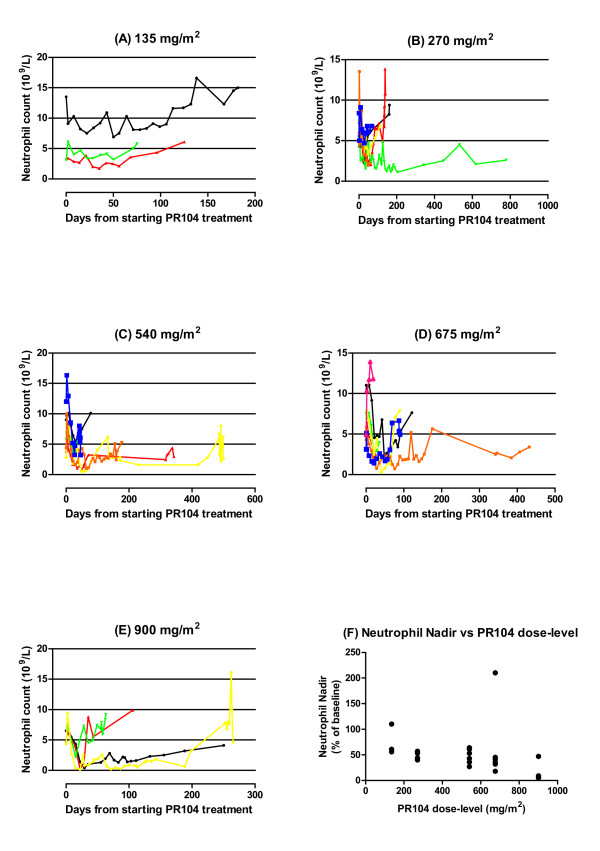
PR-104-induced neutropenia followed until death or further treatment. (a) Time-course of neutropenia in each subject at 135 mg/m2 (b) ime-course of neutropenia in each subject at 240 mg/m2 (c) Time-course of neutropenia in each subject at 540 mg/m2 (d) Time-course of neutropenia in each subject at 675 mg/m2 (e) Time-course of neutropenia in each subject at 900 mg/m2 (f) Neutrophil nadir on first treatment cycle correlated with PR-104 dose-level (Spearman r = -0.56; P < 0.005)